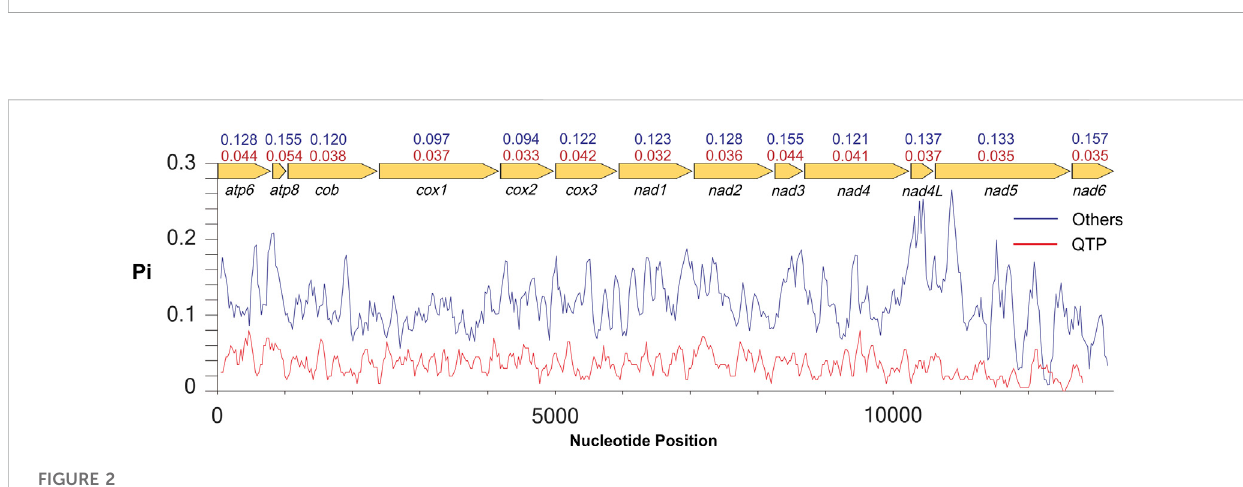
FIGURE 1 Size comparison of protein-coding genes (PCGs), transfer RNA genes (tRNAs), rrnL , rrnS , and control region (CR) among 13 Lycaenidae mitogenomes. Species are abbreviated as follows: Cb, Curetis bulis ; Ct, Cigaritis takanonis ; Lp, Lycaena phlaeas ; Cr, Coreana raphaelis ; Ps, Protantigius superans ; Hq, Hypaurotisquercus ; Jl, Japonica lutea ; Sd, Shijimiaeoides divina ;Ca, Cupido argiades ;Pa, Polyommatus amorata ;NQ2, Agriades orbitulus NQ2; NQ1, Agriades orbitulus NQ1; MY, Agriades orbitulus MY.